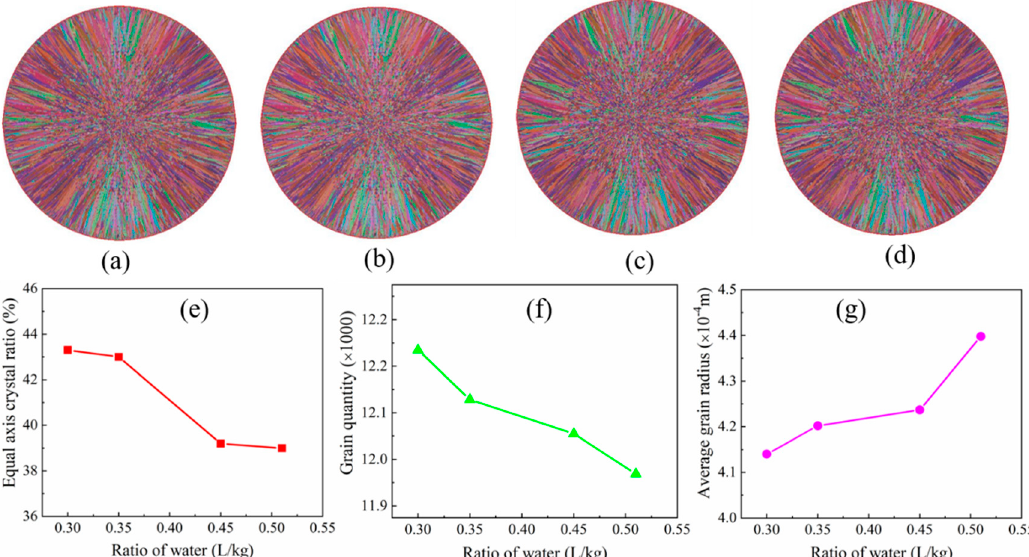
Figure 7. Influence of the casting speed on the solidification structure ( a – d ): solidification structure morphology at specific water flows of 0.30, 0.35, 0.45, and 0.51 L/Kg, respectively; ( e – g ): changes of equiaxed crystal ratio, grain number, and average grain radius with specific water flow, respectively.